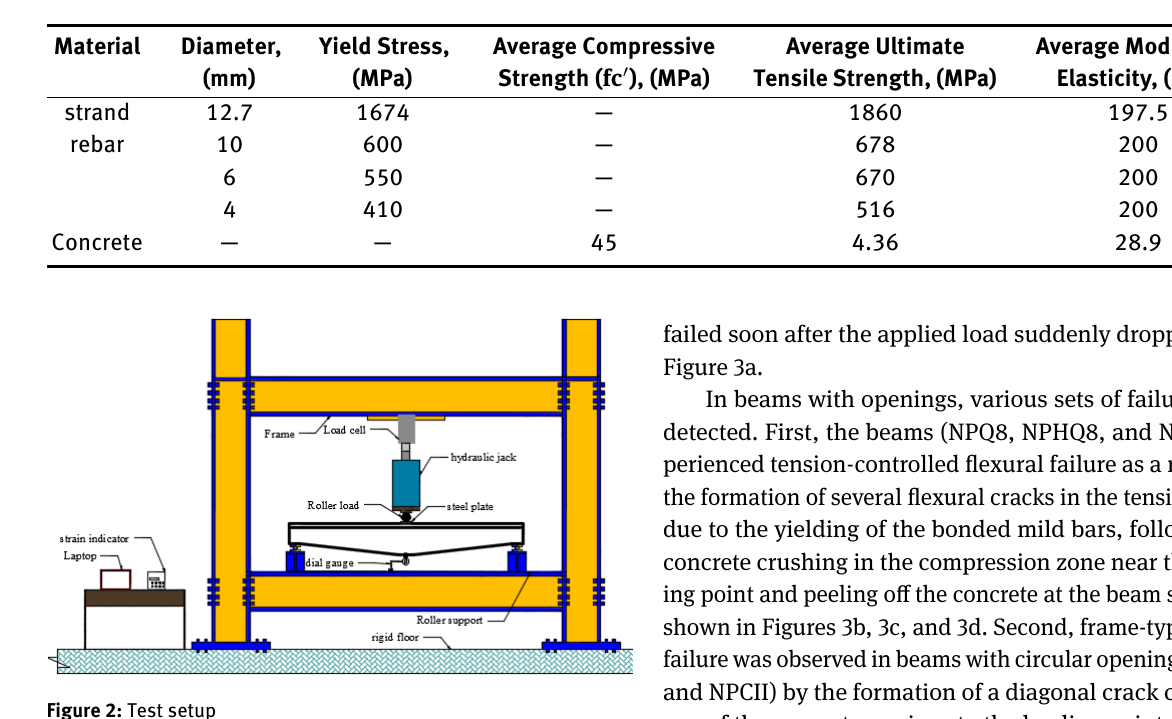
Table 2: Material properties